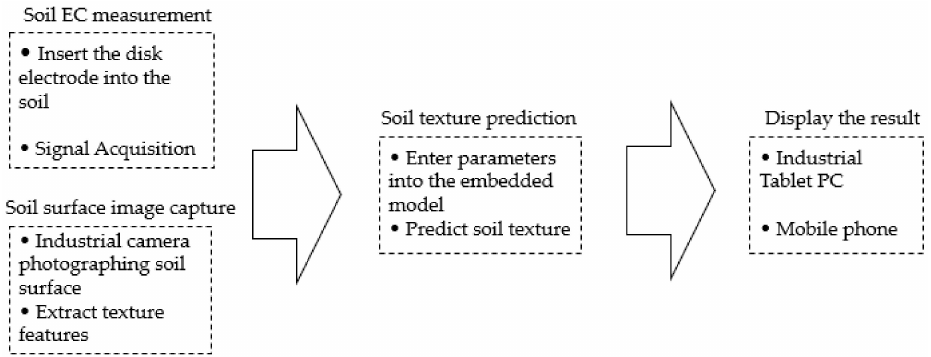
Figure 1. Flow chart of soil texture prediction.